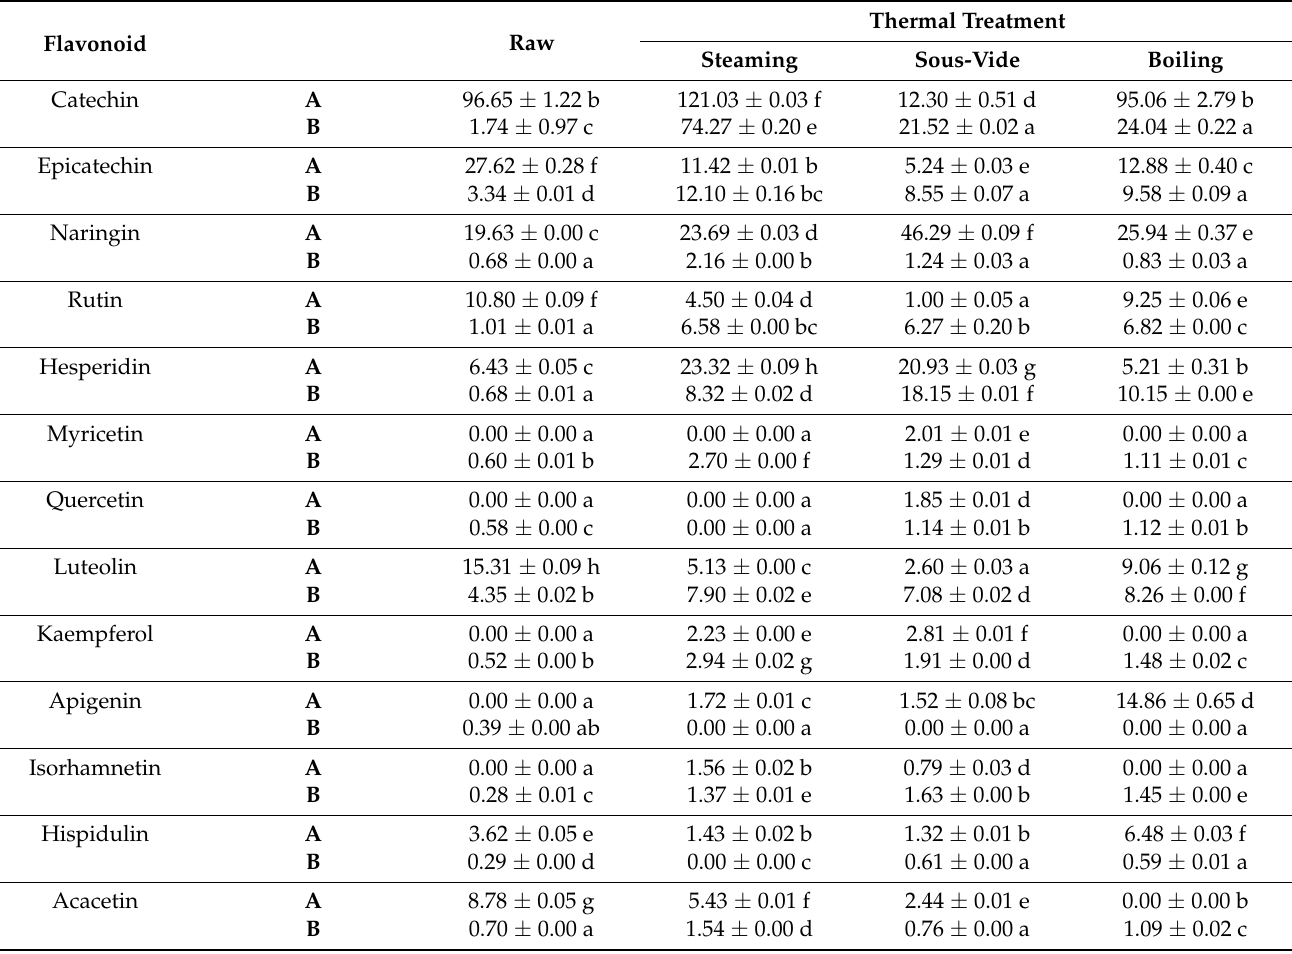
Table 2. Flavonoids concentration (mg/kg f.m.) in raw and thermally-treated Brussels sprouts before and after in vitro